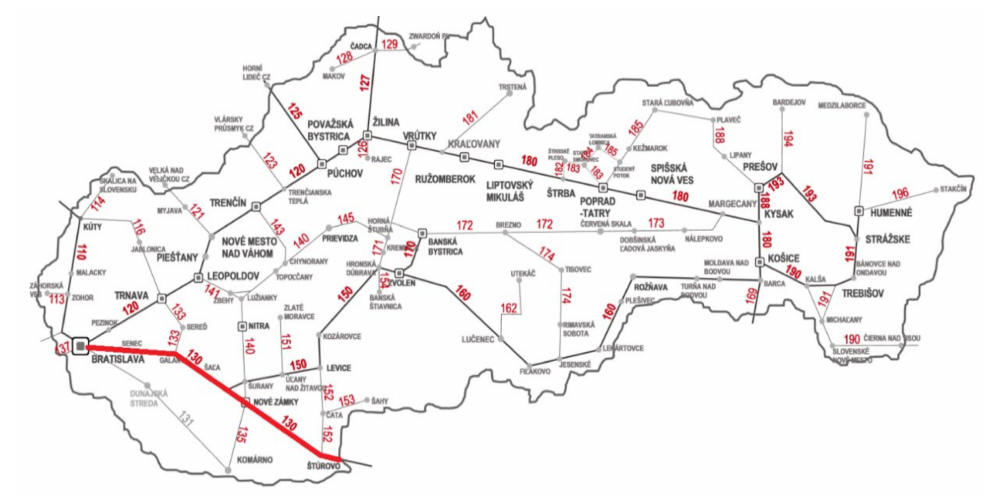
Figure 5. ŽSR 130 route marked in red on the map.